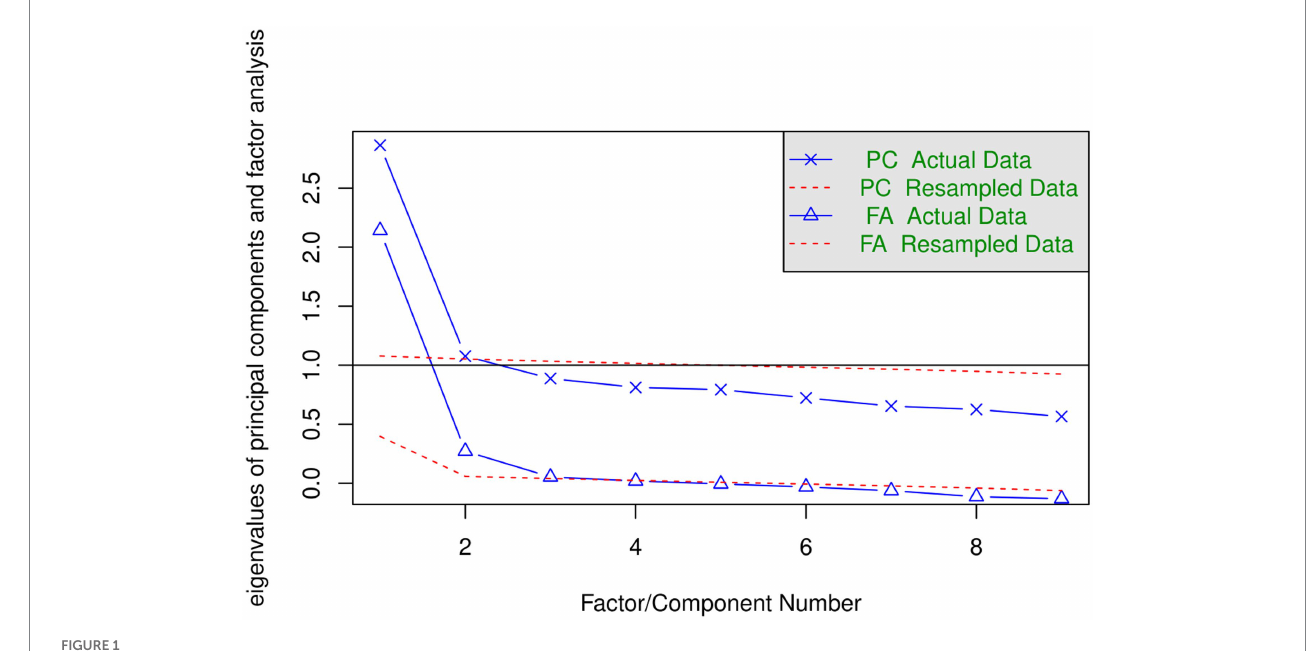
FIGURE 1 Scree plots for PCA and FA runs.